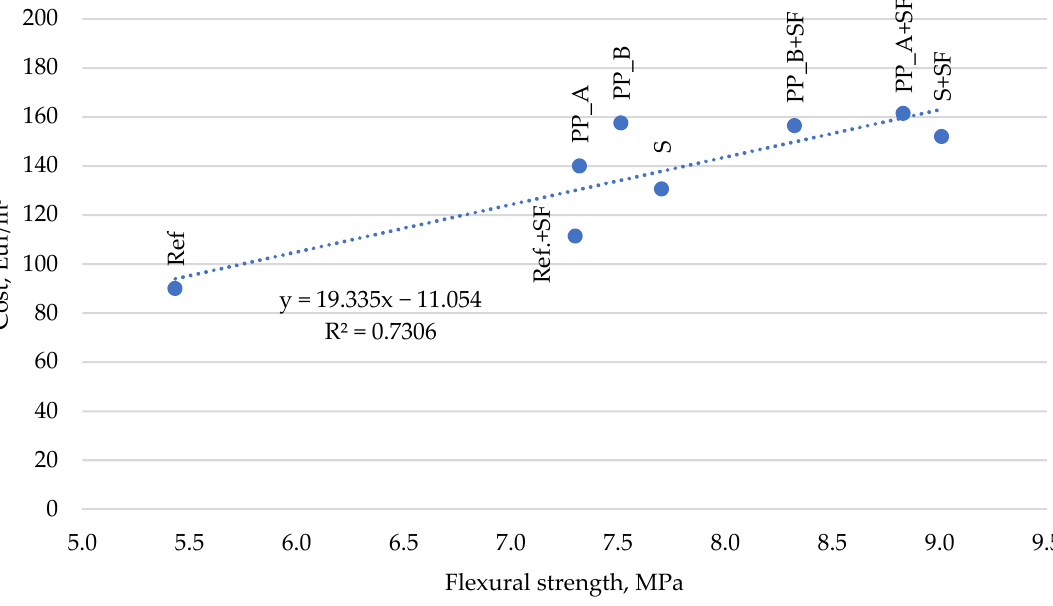
Figure 8. Cost of fresh concrete in terms of flexural strength.